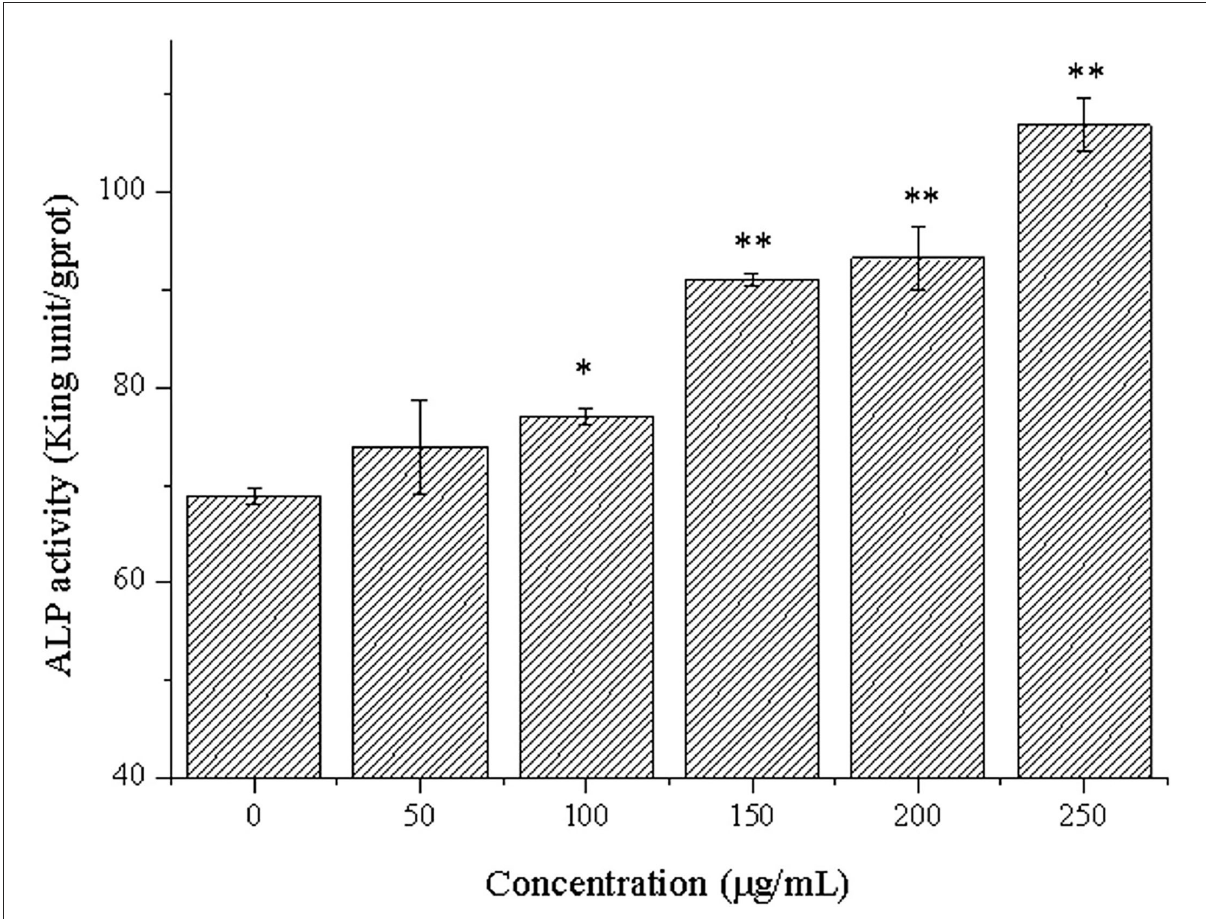
FIGURE5 ALP activity of MC3T3-E1 cells treated with CPP-Ca (50, 100, 150, 200, and 250 µ g/mL). * p < 0.05; ** p < 0.01, compared with the control